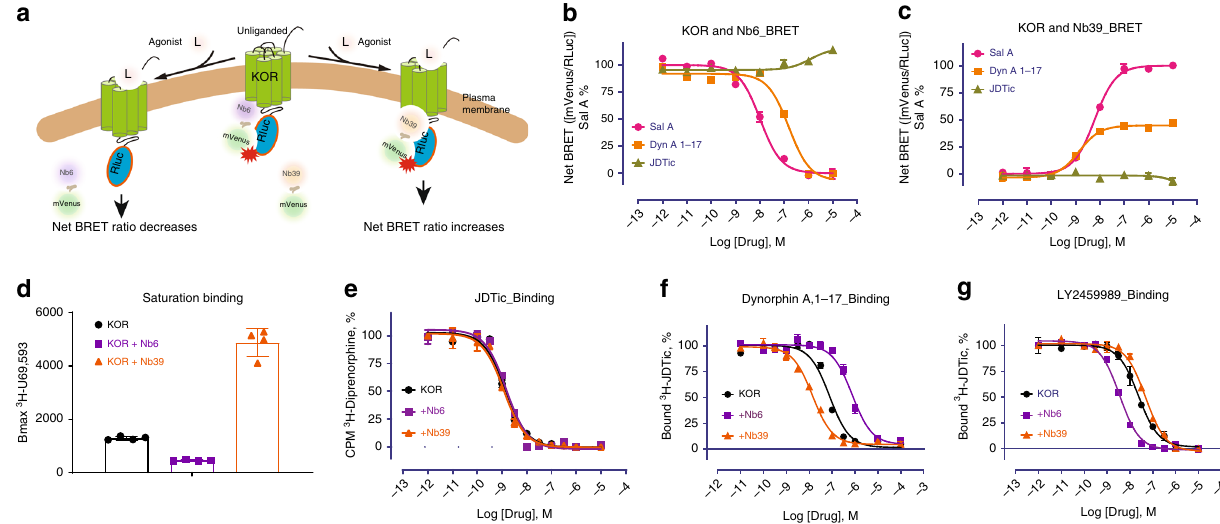
Fig. 1 Molecular pharmacology of Nb6 and Nb39. a Schematic of Nb6 and Nb39 interaction with KOR in BRET-based assay. b Agonist-induced dissociation of Nb6 from the KOR detected by BRET assay. EC50: Sal A (10.2 ± 0.15 nM); Dynorphin A (155.6 ± 28.6 nM). Note that concentration at − 12 represents no-drug added. Net BRET ratio was obtained by the signal (KOR + Nb6) minus signal (KOR) . Each data point represents a mean ± s.d. in error bars ( N = 5, fi ve experiments each done in duplicate) c Agonist-induced association of Nb39 with the KOR detected by BRET assay. EC50: Sal A (6.04 ± 0.54 nM); Dynorphin A (1.38 ± 0.17 nM). Each data point represents a mean ± s.d. in error bars ( N = 5, fi ve experiments each done in duplicate). d Saturation binding of the agonist radioligand 3 H-U69,593 at KOR in the presence of Nb6 or Nb39. Bmax value from the saturation curve was obtained by fi tting to the one-site saturation model in Graphpad Prism. c.p.m., counts per minute. Bmax value: 1288 for KOR untreated; 455 for KOR + Nb6; 4880 for KOR + Nb39. ( N = 3, three experiments each done in duplicate). e – g Binding af fi nity of the antagonist JDTic ( e ), endogenous agonist Dynorphin A ( f ) and neutral antagonist LY2459989 ( g ) in the presence of Nb6 or Nb39. The statistical values are quanti fi ed in Supplementary Table 2 by fi tting to the “ one site- fi t Ki ” program in GraphPad Prism. Error bars represent SEM. ( N = 3, three experiments each done in duplicate). Source data are provided as a Source Data fi